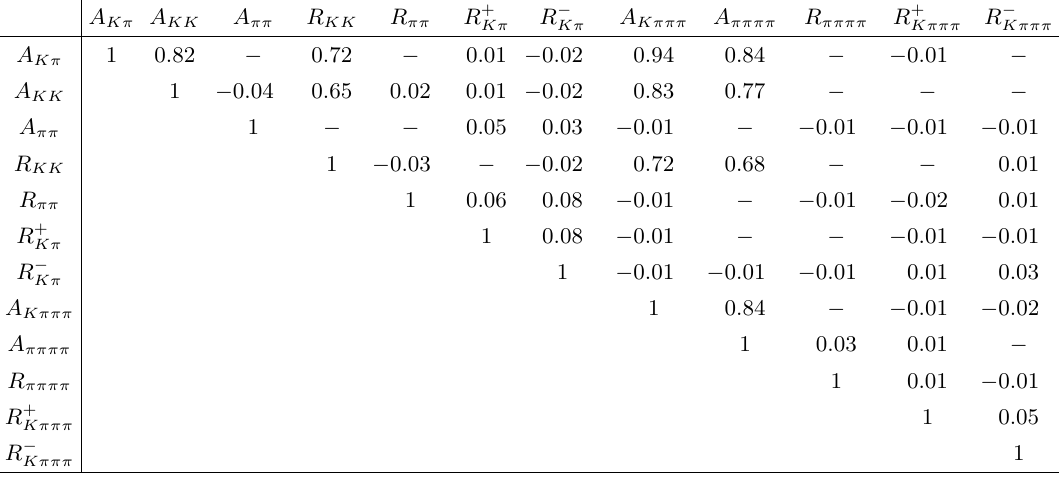
Table 4. Correlation matrix of the systematic uncertainties for the twelve physics observables from the simultaneous (cid:12)t to data. Only half of the symmetric matrix is shown.